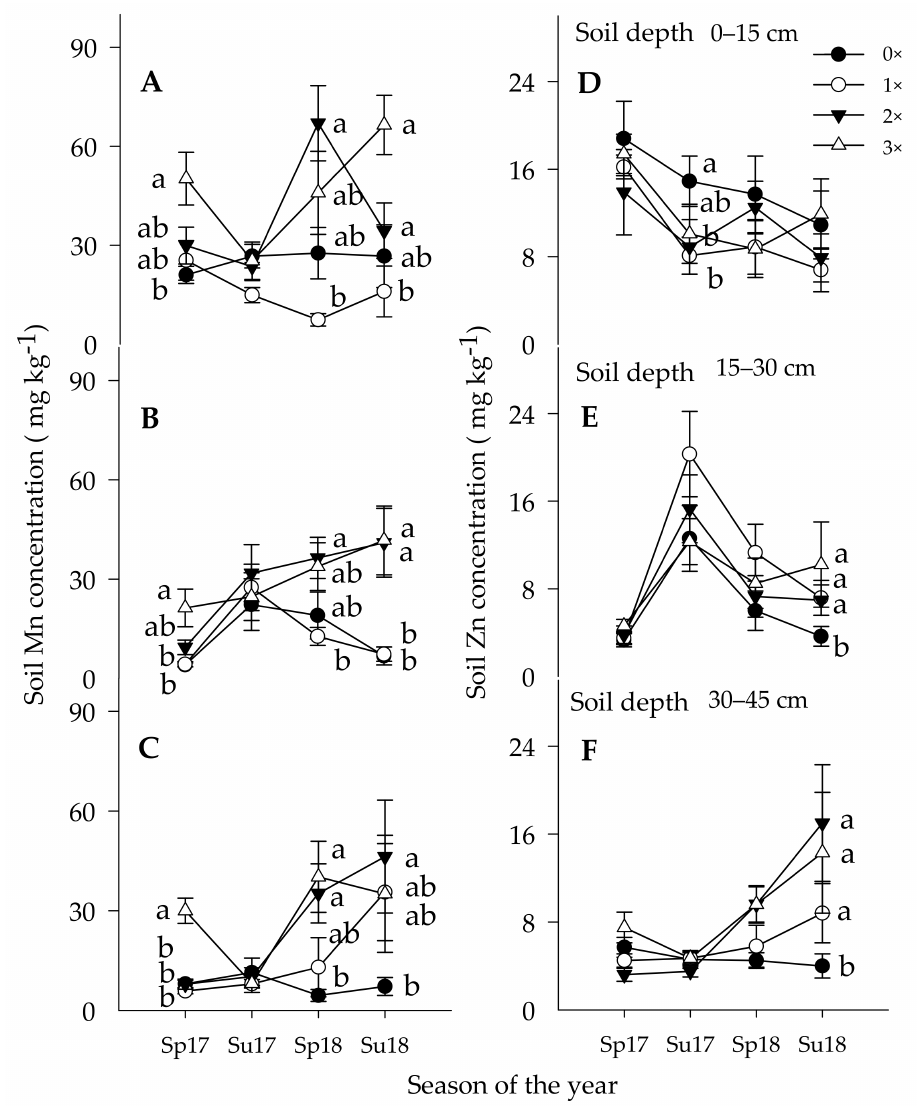
Figure 2. Soil Mn (figures ( A – C )) and Zn (figures ( D – F )) movement and accumulation in three soil depths: 0–15, 15–30, and 30–45 cm under Huanglongbing-affected Hamlin citrus trees in spring (sp, Feb. /Mar) and summer (su, Aug. /Sept.) seasons. Micronutrient treatments: control (0 × , closed circles), foliar (1 × ) (1 × , open circles), foliar (1 × ) coupled with the ground (1 × ) (2 × , closed triangles), and foliar (1 × ) and the ground (2 × ) (3 × , open triangles), (1 × = 9 kg ha − 1 of metallic Mn and Zn each and 2.3 kg ha − 1 of B). Error bars denote mean ± standard error of means ( n = 36). Means along the same vertical alignment with the same lower case letters are not significantly different ( p ≤ 0.05) using the Tukey's range